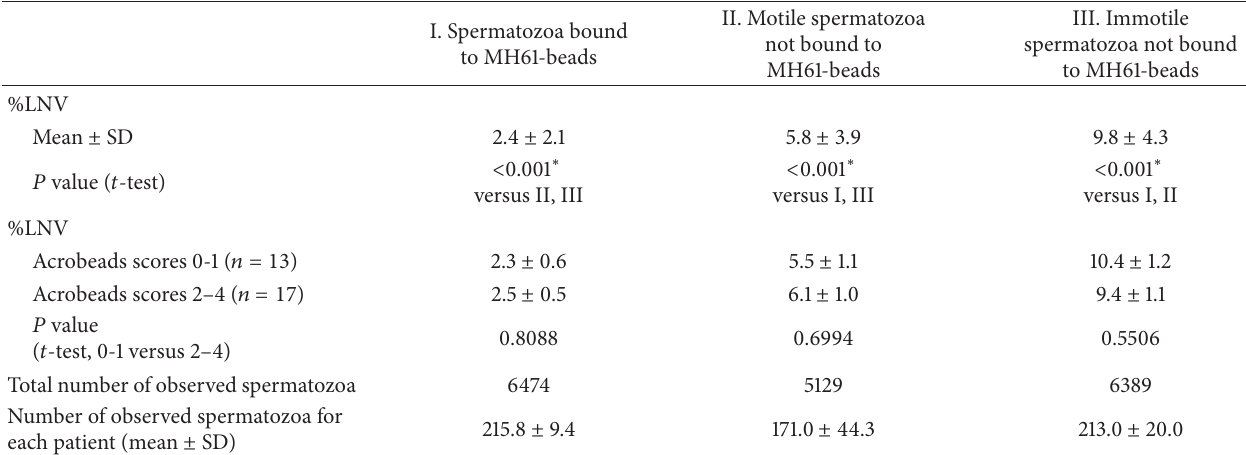
Table 2: Proportion of spermatozoa with large nuclear vacuoles according to the state of binding to MH61-beads and motility ( 𝑛 = 30